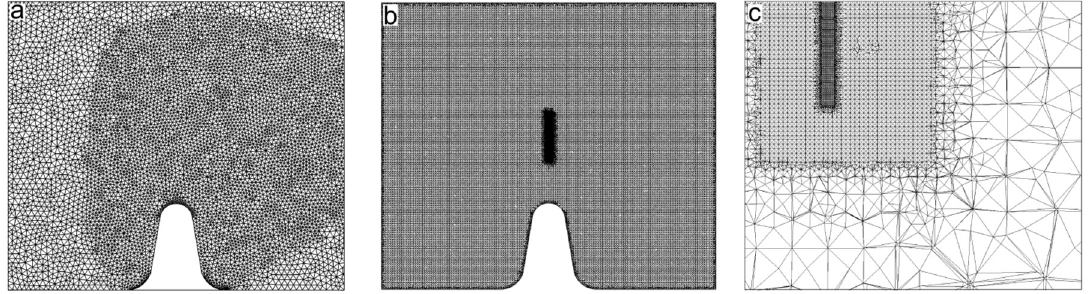
Figure 8. Meshes used in the headland case example: ( a ) the coastal area model; ( b ) the BEM-CFD model; and ( c ) a close up of the BEM-CFD mesh showing the gradation to finer regions around the